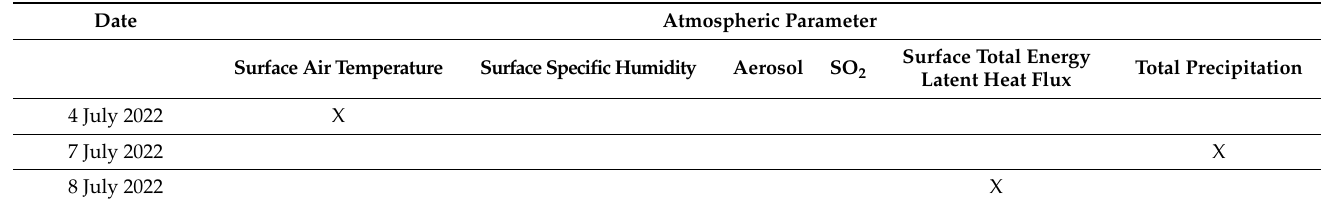
Table 2. List of the atmospheric anomalies identified inside the square area of 3 ◦ sides, centred on the ML3.3 Guidonia 1 January 2023 earthquake. The parameter which is anomalous on a specific day is marked with a “X” in the